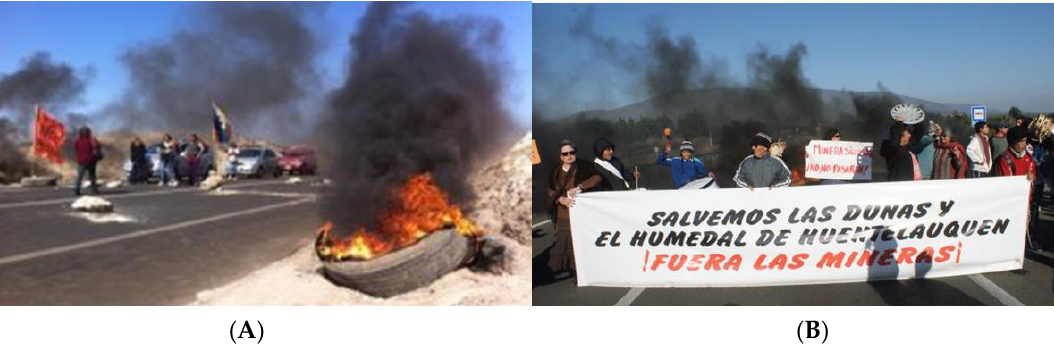
Figure 5. Anti-miming protests Source: [65,66]. Picture ( A) shows how commoners place burning tires to stop the traffic of the Highway to protest. The banner of the picture ( B) says: “Let save the dunes and the wetlands of Huentelauquén, Mining companies out!”.